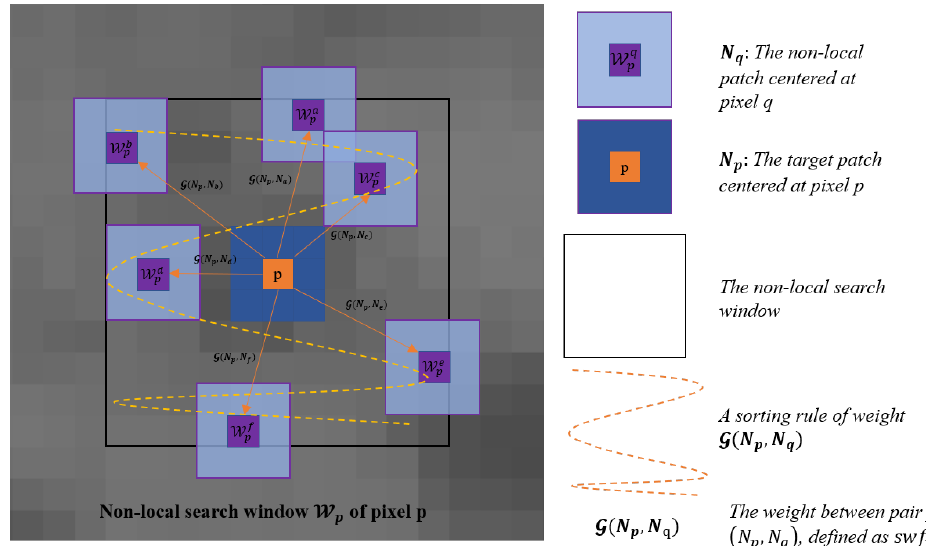
Figure 1. Illustration of constructing the proposed non-local structure weight feature. Taking the p th pixel as an example, the non-local search window W p has the size ( 2 w 2 + 1 ) × ( 2 w 2 + 1 )